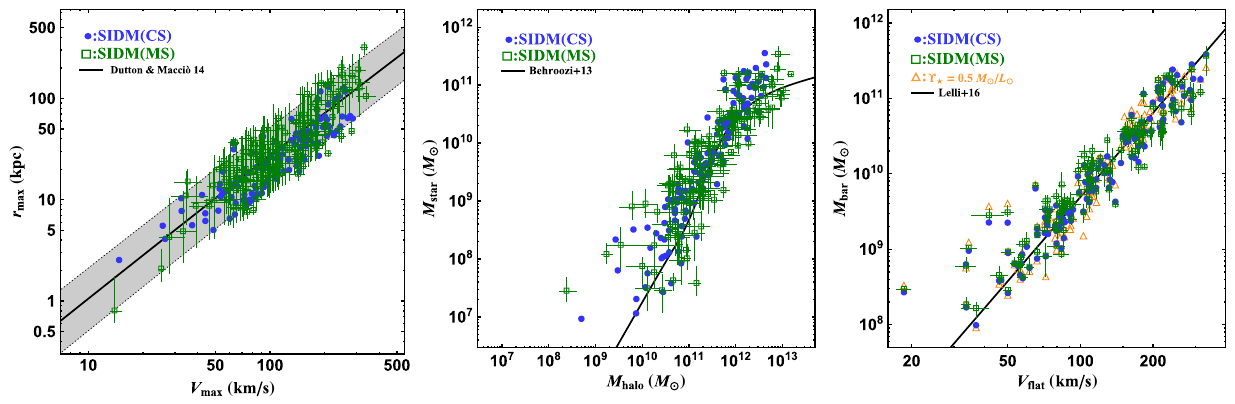
− V FIG. 3. Left panel: r distributions of the host halos in the SIDM fits with controlled (circles) and MCMC (squares) max max samplings. We also show the mean relation (black solid line) and 2 σ scatter (gray shaded area) predicted in cosmological CDM simulations [37]. Middle panel: Halo virial mass vs galaxy stellar mass from the SIDM fits. The black solid line corresponds to the abundance matching inference from Ref. [58]. Right panel: Total baryonic mass vs flat circular velocity for the 135 galaxies, where M is inferred from our SIDM fits (circles and squares). For comparison, we also show the case (triangles) when ϒ ⋆ to 0 . 5 M ⊙ =L ⊙ [54]. The black solid line is the mean baryonic Tully-Fisher relation from Ref. [54], derived from 118 SPARC galaxies ¼ ϒ ¼ 0 . 5 M with ϒ ⋆ ⋆ ; bulge ⊙ =L ⊙ , at which the scatter is ; disk